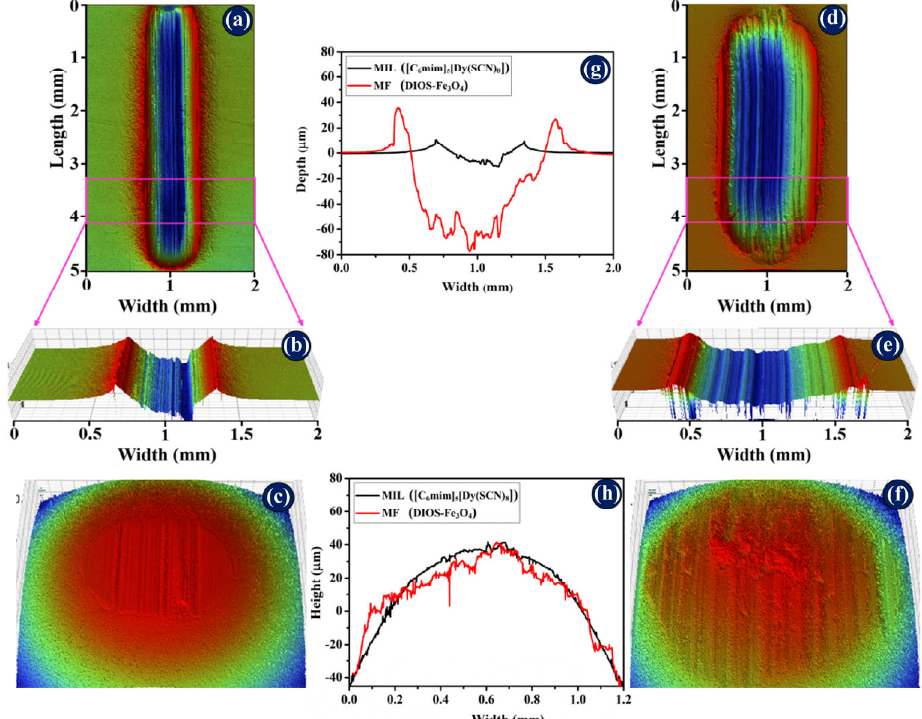
Fig. 10 3D images of wear scars and partially enlarged pictures of wear scars of a steel disk and upper steel ball lubricated by (a–c) the MIL and (d–f) MF, as well as (g, h) 2D wear scar depth profiles at 100 N and 150 °